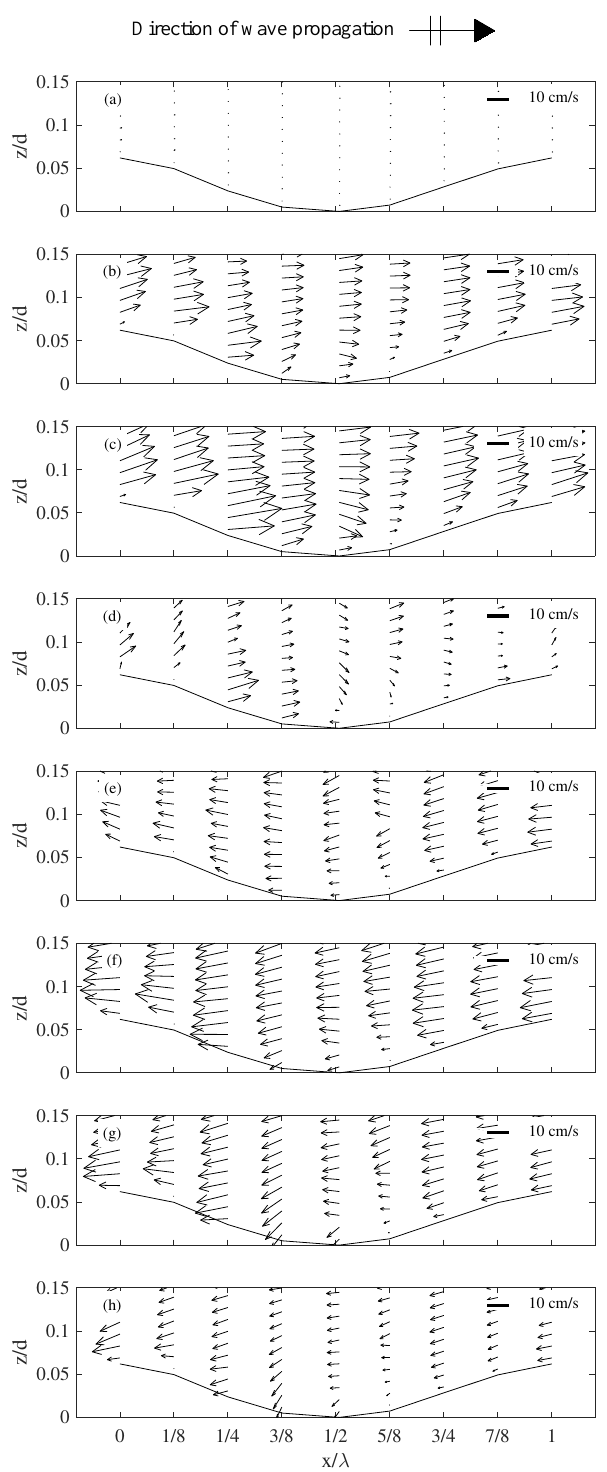
Figure 13. T 9 test ( H = 5.86 m, T = 1.26 s), velocity field along ripple P 2 at eight phases: ( a ) 0; ( b ) 1/4 π ; ( c ) 1/2 π ; ( d ) 3/4 π ; ( e ) π ; ( f ) 5/4 π ; ( g ) 3/2 π ; and ( h ) 7/4 π